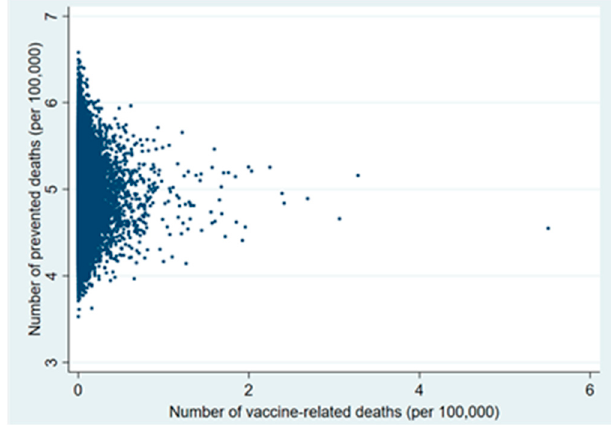
Figure 6. Probabilistic sensitivity analysis. Number of vaccine-prevented deaths for COVID-19 (benefit) vs. vaccine-related deaths for disseminated intravascular coagulation and cerebral venous sinus thrombosis (risk) after 100,000 simulations. Individuals aged 50–59 years, Italy.